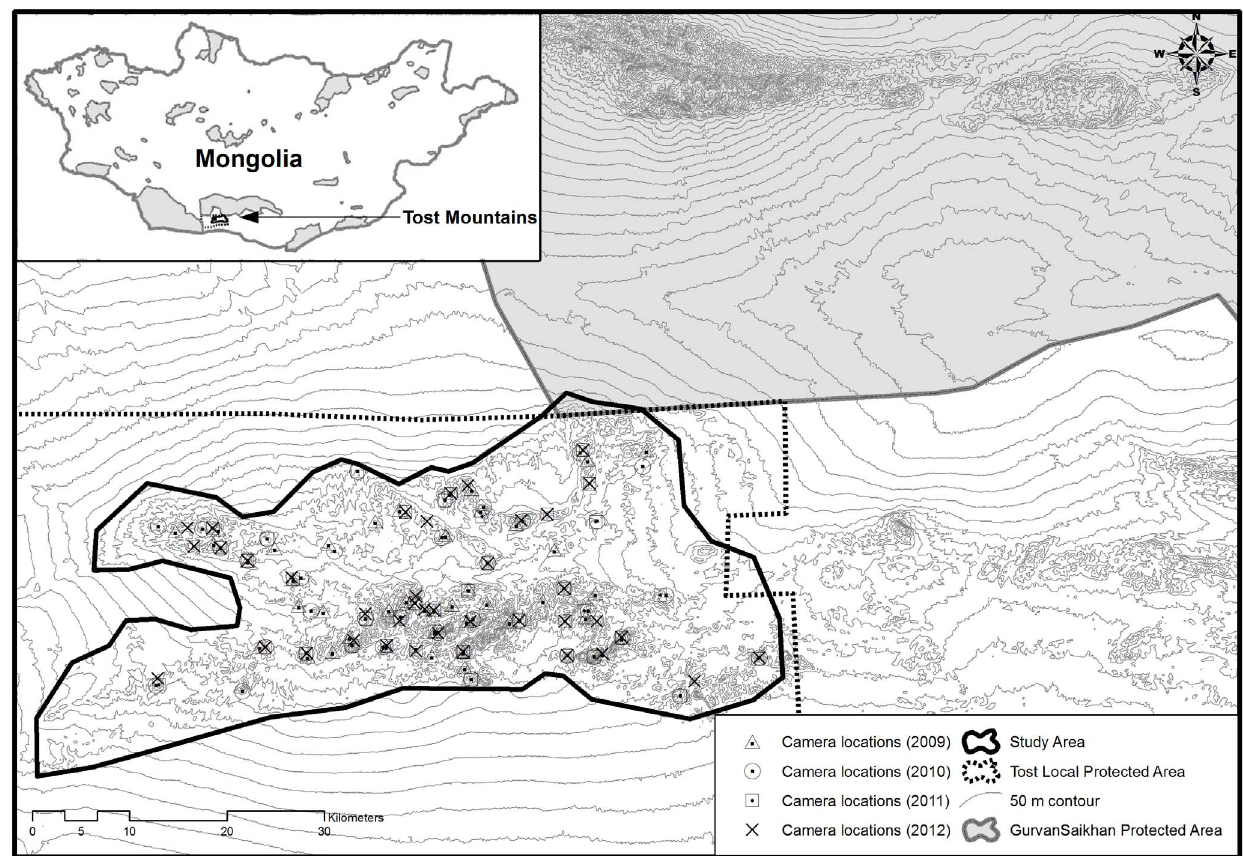
Figure 1. Location of camera traps from 2009 to 2012 in the Tost Mountains in South Gobi, Mongolia, where the population monitoring study of snow leopards was conducted. The camera locations were adjusted every year within the study area after conducting fresh surveys to ensure best camera placements for the year.